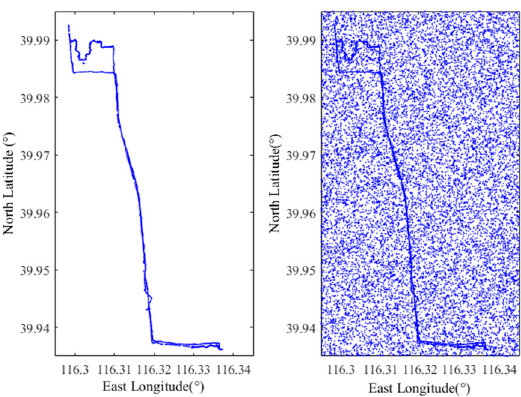
Figure 2. The schematic of long-term statistical attack (LSA).